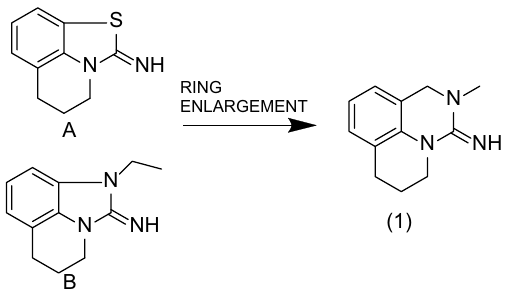
Figure 1. Identification of tricyclic lead (1) from screening hits ( A ) and ( B ). IC 50 on human NNMT are 1.6 µM ( A ), 0.18 µM ( B ) and 0.13 µM